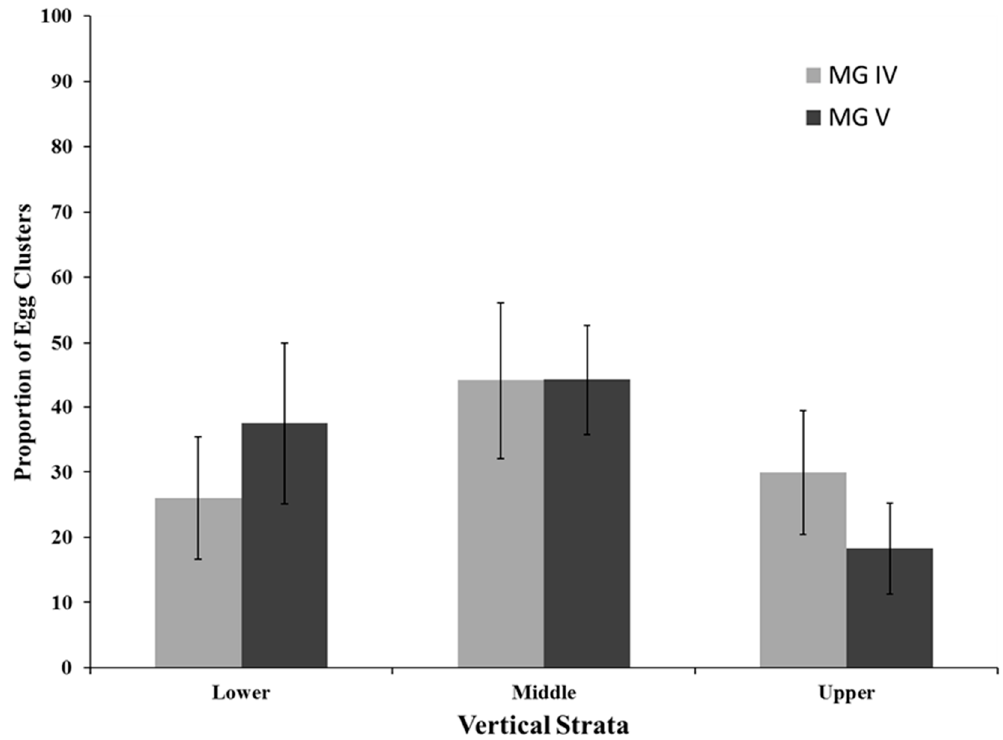
Figure 2. Oviposition site preference of redbanded stink bug within vertical strata in MG IV and MG V soybean. Table 2. Redbanded stink bug oviposition preference during reproductive growth stages a .